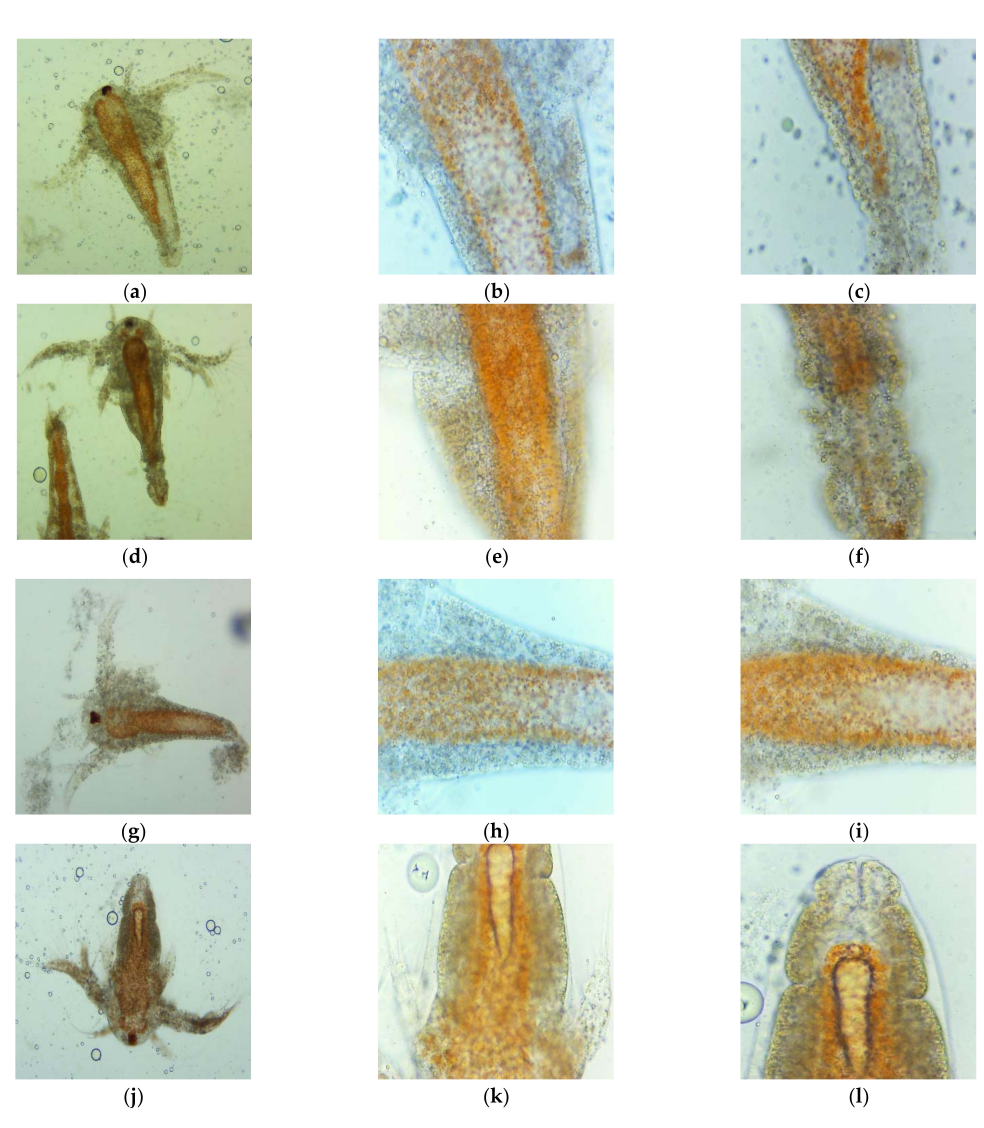
Figure 6. Morphological changes induced by UBO ( a – c , g – i ) and CNO ( d – f , j – l ): 1:1 ( a – f ) and 2:1 ( g – l ) on A. salina larvae after 24-h exposure, in microscopical images at different magnifications: 100 × ( a , d , g , j ) and 400 × ( b , c , e , f , h , i , k , l